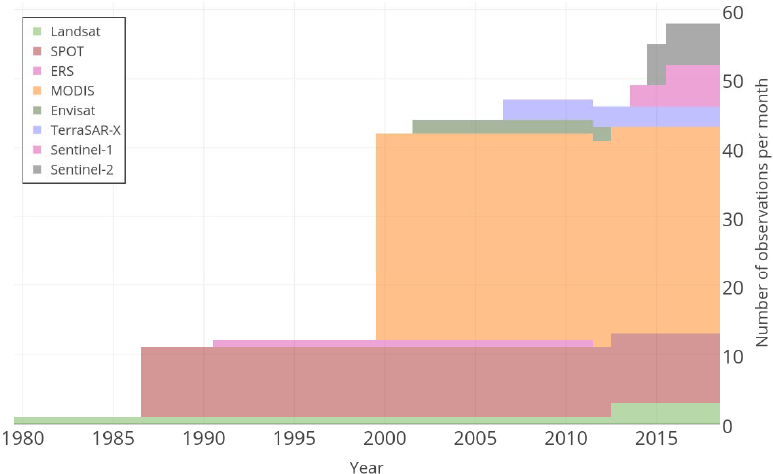
Figure 1. The number of available satellite images has improved significantly over the last three decades. In this figure, the variety of spatial resolution in the different missions is not